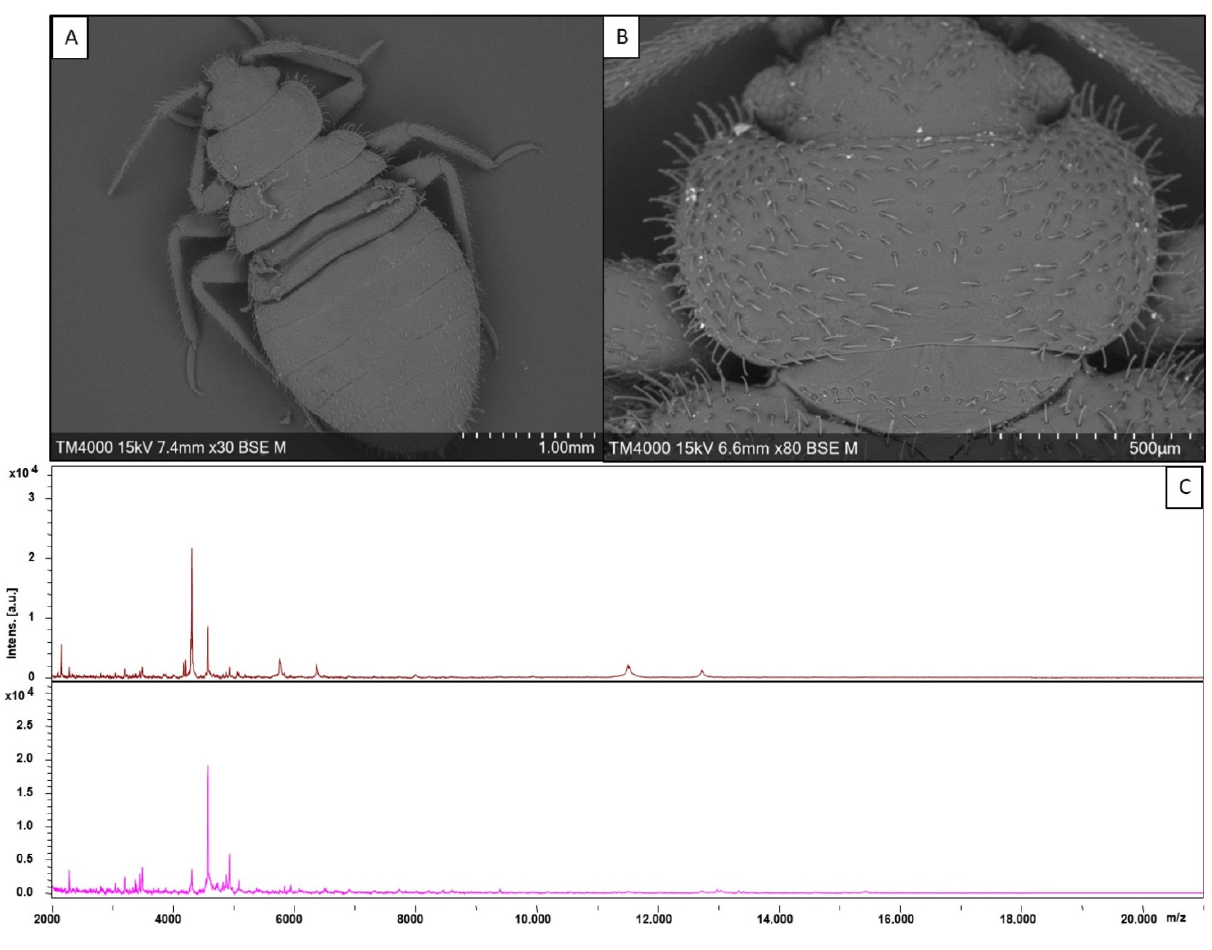
Figure 2. ( A ) Electron microscopy photograph of an immature specimen of Cimex hemipterus. ( B ) Electron microscopy photograph of the pronotum of an immature specimen of C. hemipterus . ( C ) Representation of species-specific Matrix-assisted Laser Desorption-Ionization Time-Of-Flight Mass Spectrometry Mass Spectra obtained through analysis of two immature specimens of C. hemipterus , collected in Mauritania between September 2021 and October 2021. The y axis refers to intensity and is expressed in arbitrary units ([a.u.]). The x axis refers to the mass to charge ratio ( m / z ).